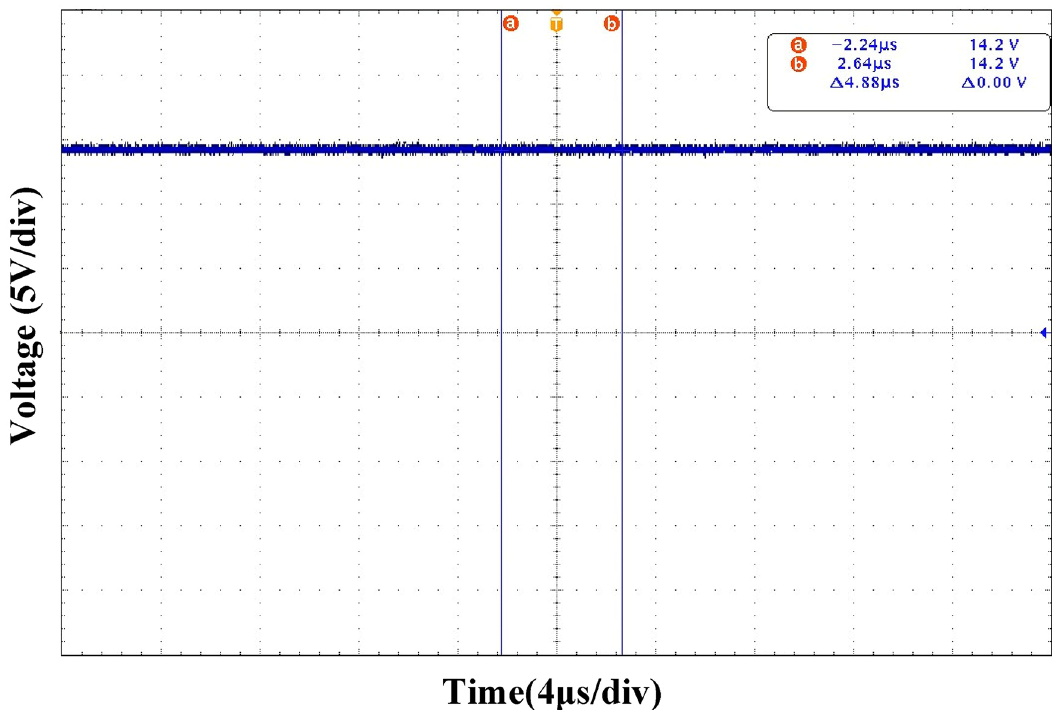
Fig 26. Output voltage waveform under ATSMC control